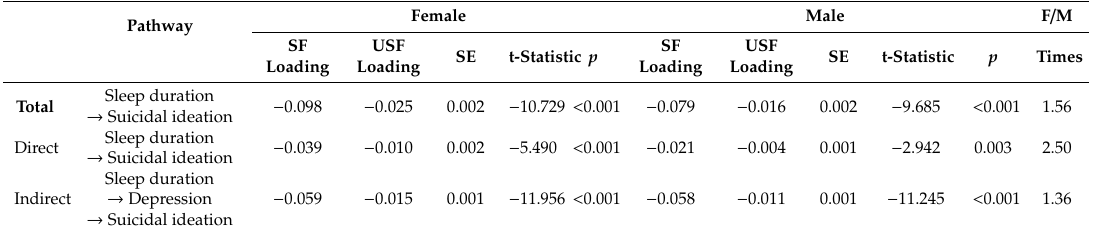
Table 6. Decomposition of direct and indirect e ff ects of sleep duration on suicidal ideation.